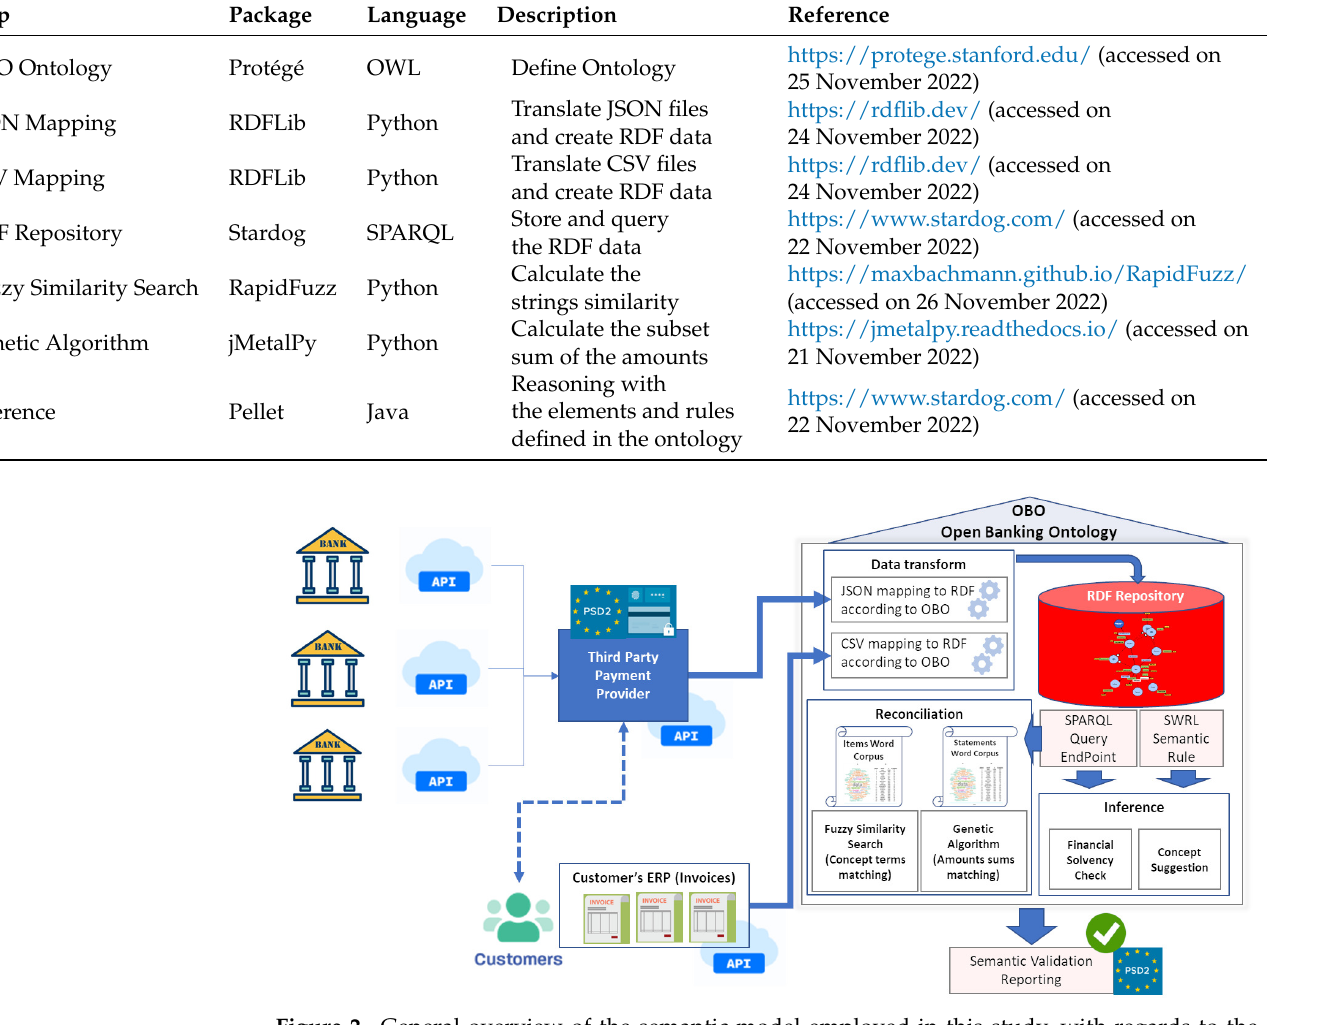
Figure 2. General overview of the semantic model employed in this study, with regards to the OBO